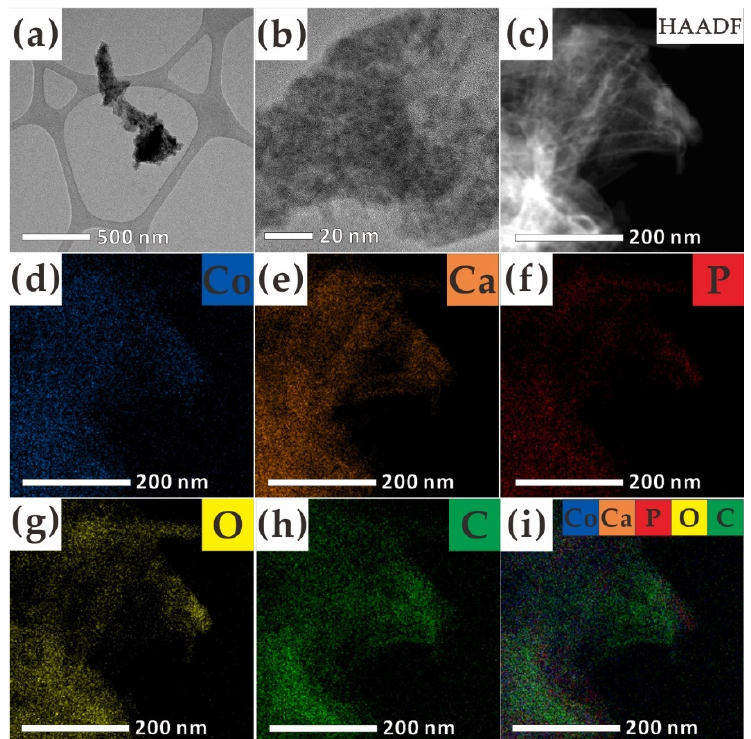
Figure 2. TEM images of ( a ) CoCaP/rGO, ( b ) a high resolution TEM image of CoCaP/rGO and EDS elements mapping of CoCaP/rGO, ( c ) a TEM image, ( d ) Co, ( e ) Ca, ( f ) P, ( g ) O, ( h ) C and ( i ) an overlapping of Co, Ca, P, O, C.